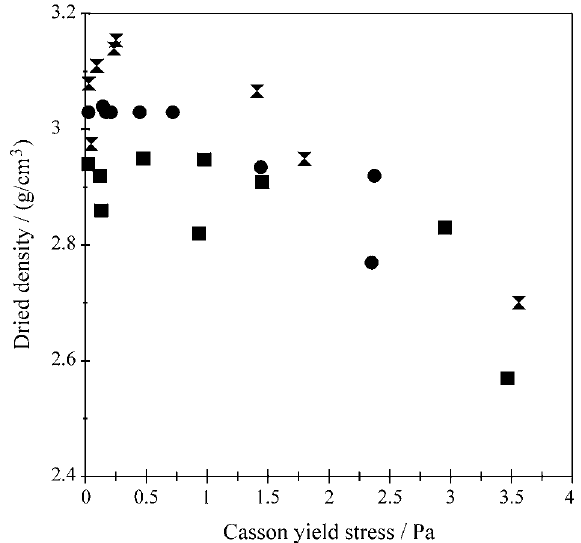
Figure 6. Relative density of green compacts prepared from 48 vol% suspensions of: • stoichiometric, with a 6 wt% excess of alumina and x with a 10 wt% excess of zircon powder mixtures by slip casting.